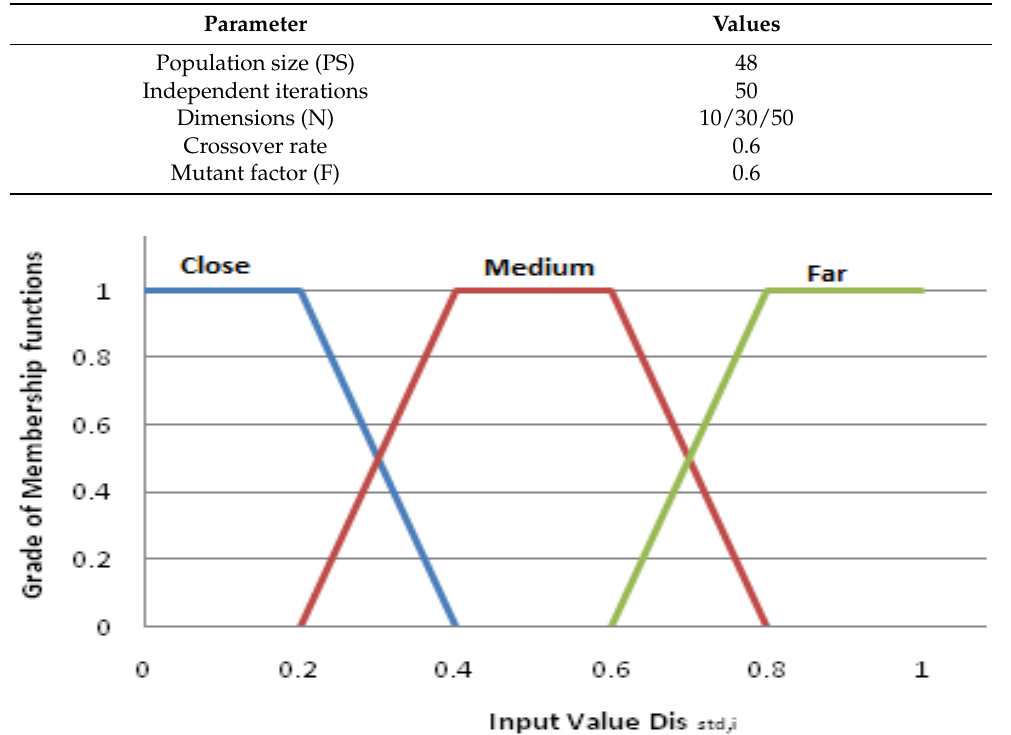
Figure 8. Membership function of input Dist std,i.